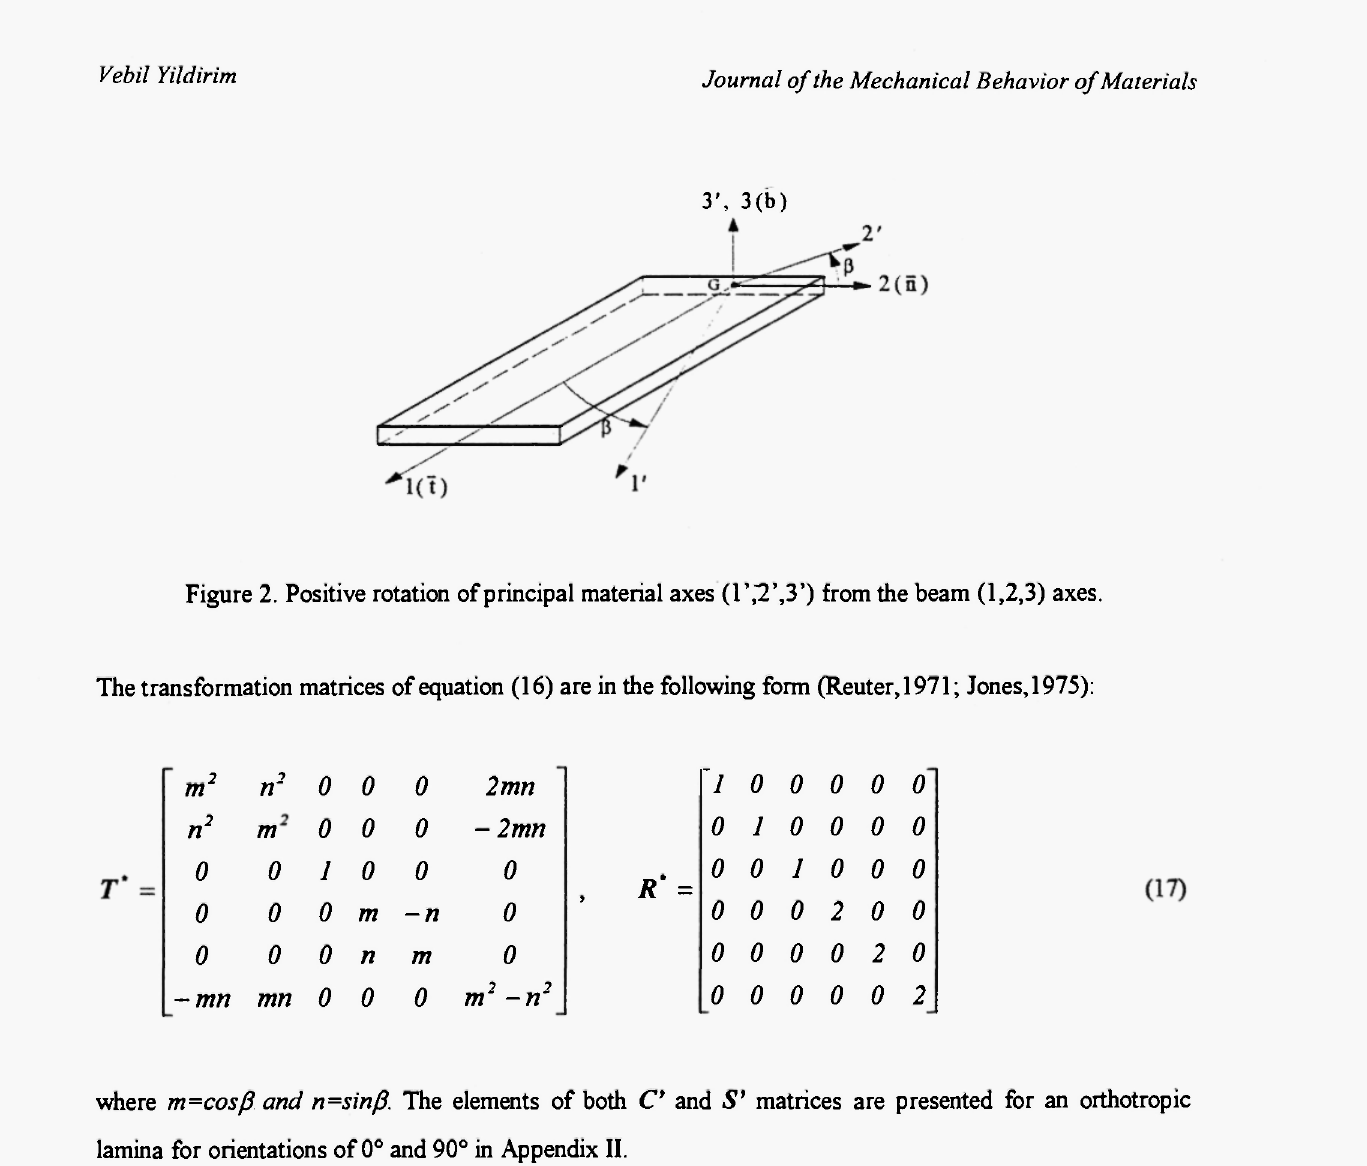
Figure 2. Positive rotation of principal material axes (Γ,Τ,3') from the beam (1,2,3)